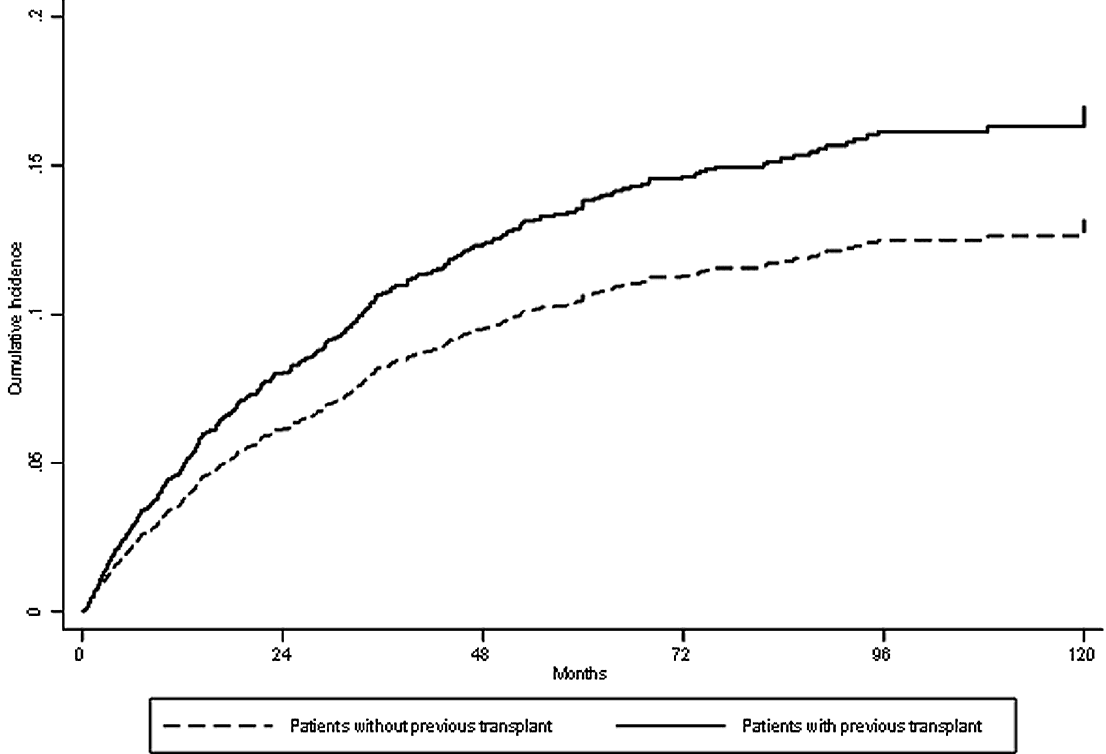
Fig 3. Estimated survival curves for death while on the waiting list in both groups adjusted for confounders using competing risk analysis.